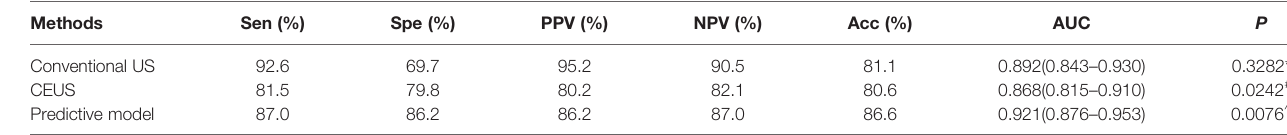
TABLE 4 | Diagnostic performance of conventional US, CEUS, and predictive model in the derivation cohort. Methods